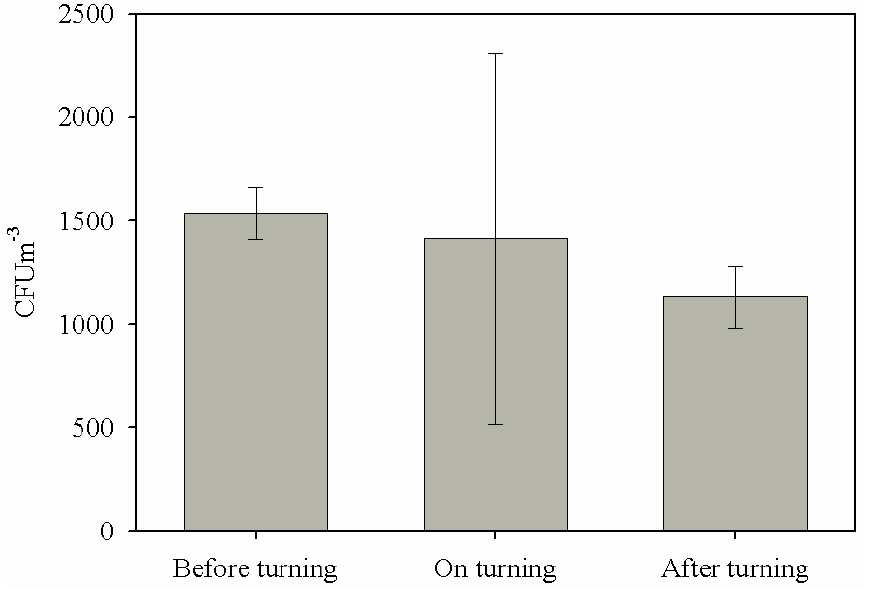
Figure 2. Mean level of airborne bacteria in swine manure composting plants according to the agitation time of the compost pile.